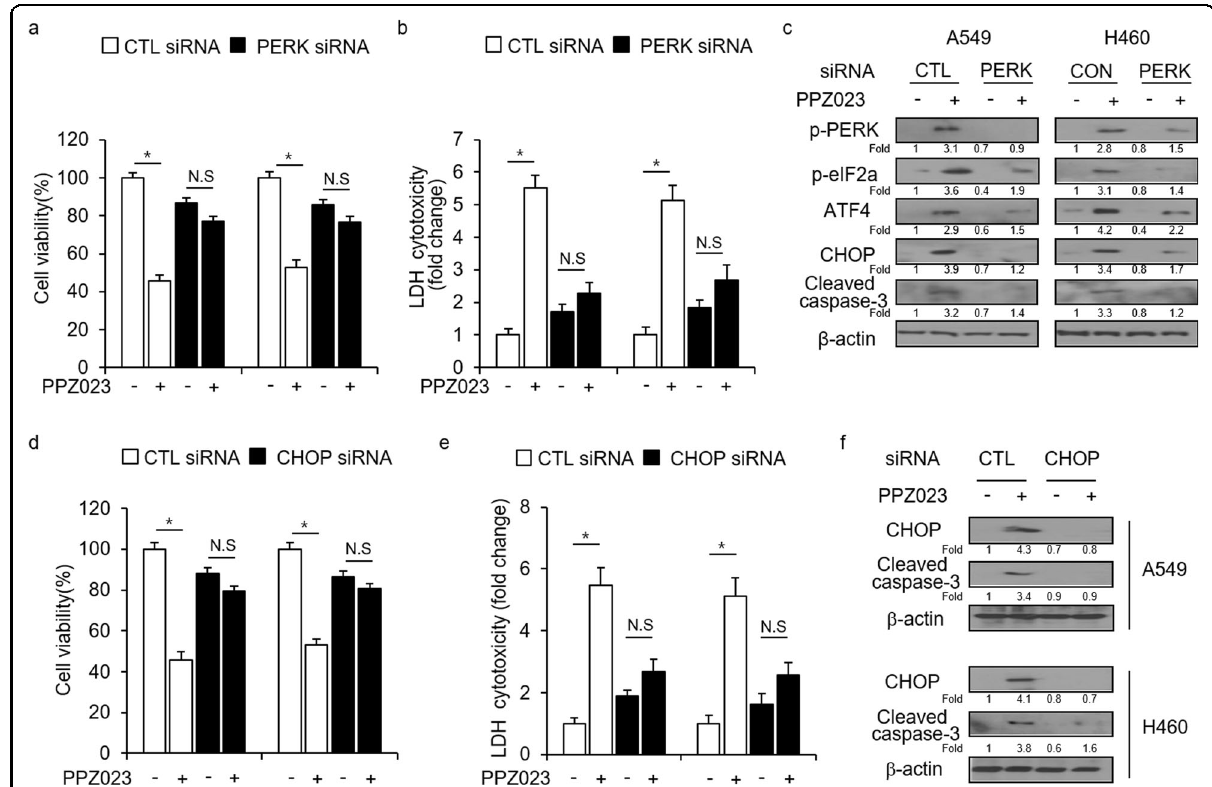
Fig. 4 Suppression of PERK signaling inhibits PPZ023-induced cell death in NSCLC cells. a – c After A549 and H460 cells were transfected with PERK siRNAs, cell viability and LDH assays were performed, and Western blot analyses of p-PERK, p-eIF2 ɑ , ATF4, CHOP, and cleaved caspase-3 levels were performed after PPZ023 (25 μΜ , 24 h) treatment; * p < 0.05. β -Actin was used as the protein loading control. d – f After A549 and H460 cells